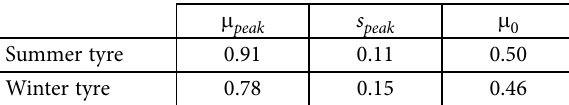
Table 2. Differences in slip referring to m peak adhesion coefficient